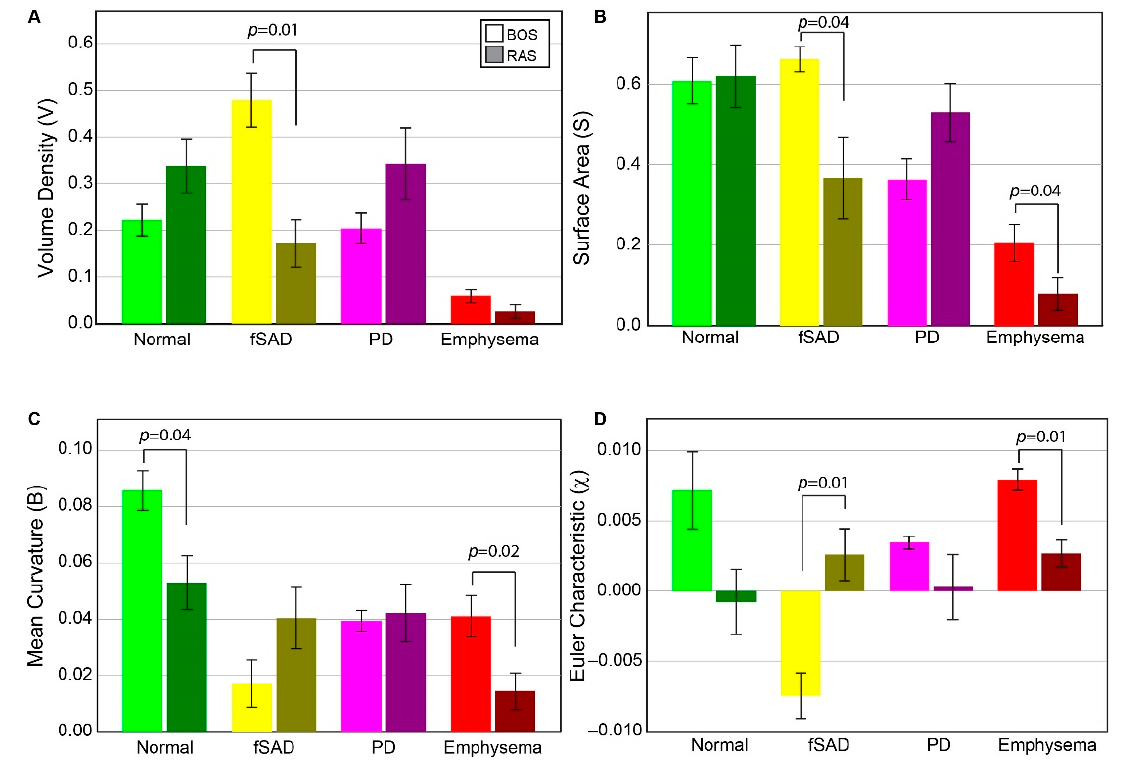
Figure 2. Chronic lung allograft dysfunction (CLAD) subtype group comparison of all tPRM met- rics. Barplots are presented as the mean and standard error of the mean for topological measures across both BOS (N = 6) and RAS (N = 6), for PRM Norm (green), PRM fSAD (yellow), PRM Emph (red) and PRM PD (magenta). BOS = Bronchiolitis Obliterans Syndrome, RAS = Restrictive Allograft Syndrome, Norm = normal parenchyma, fSAD = functional small airways disease, Emph = emphysema, PD = parenchymal disease. ( A ) Volume density, describing class magnitude (relative amounts of voxels). ( B ) Surface area, describing class exposure (exposed faces of voxels). ( C ) mean breadth, which can be interpreted as average curvature (convex/concave) of class surfaces. ( D ) Euler–Poincaré characteristic, describing class homology, determined by number and type of holes within class volumes. The legend indicates measures from BOS and RAS as light and dark shades, respectively, for a given PRM color-code.